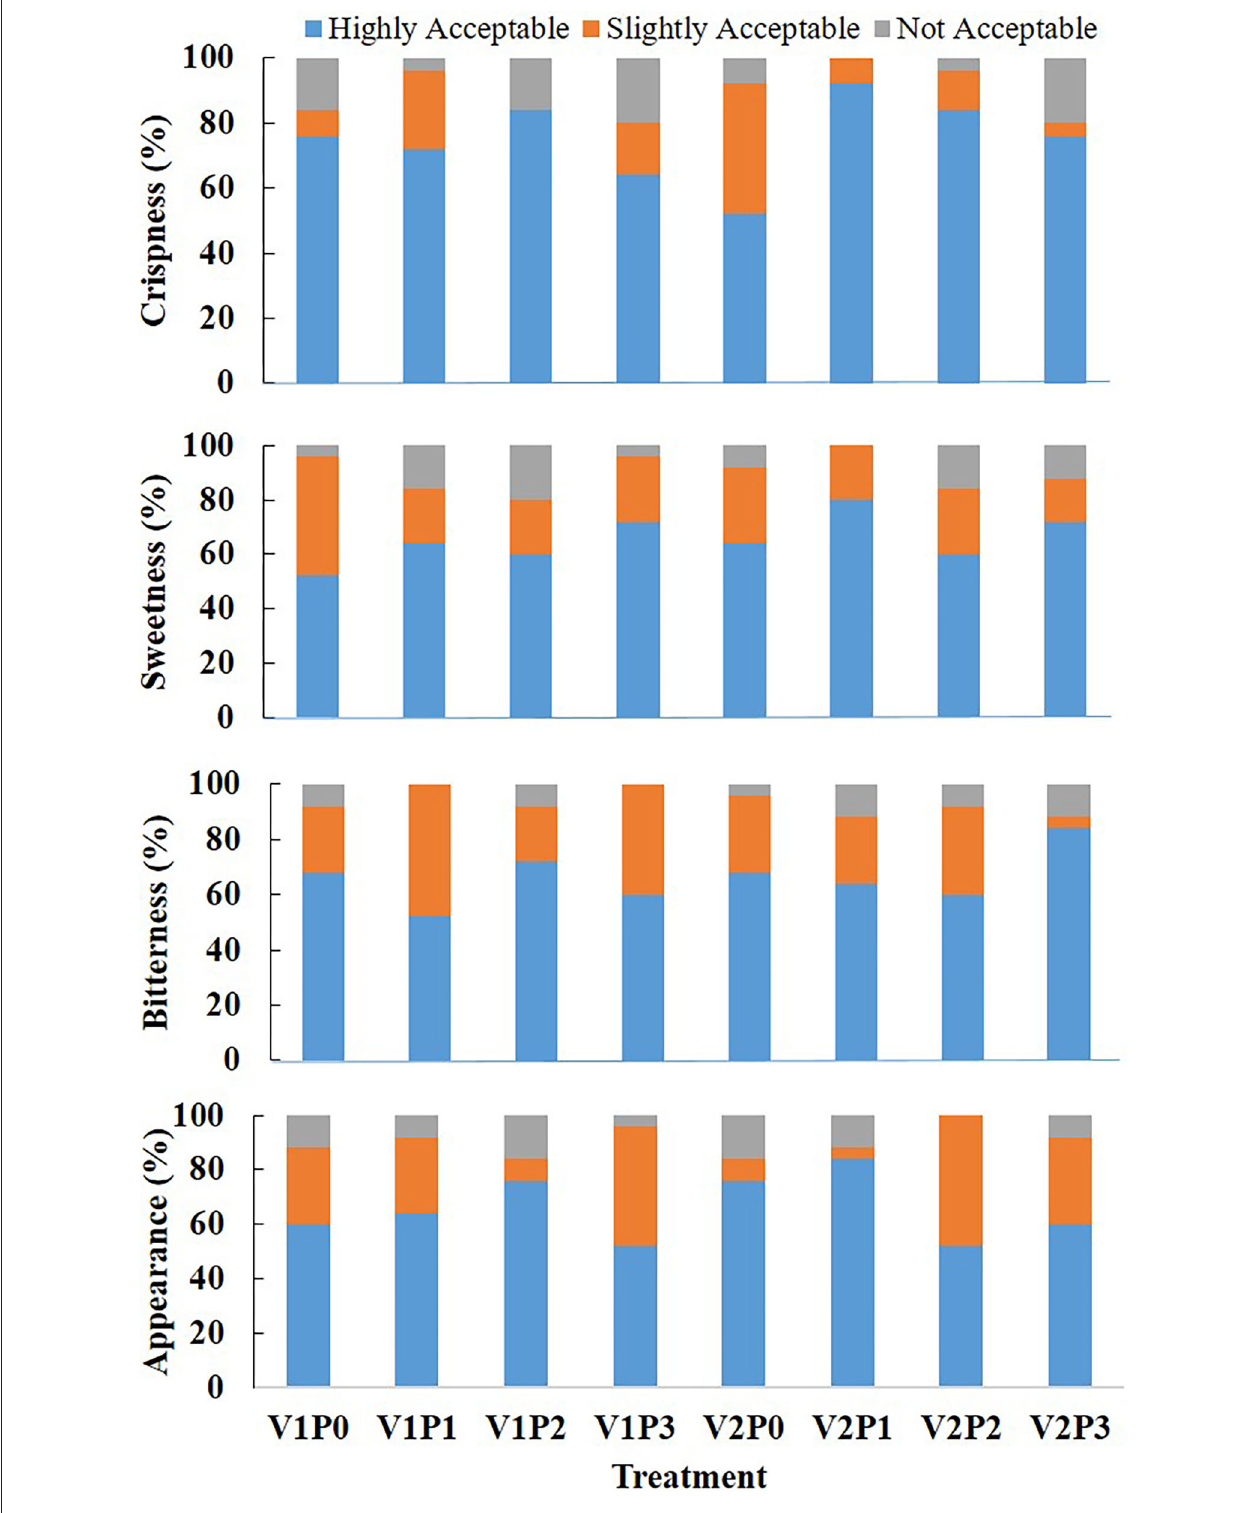
FIGURE 3 | Sensory attributes of lettuce cultivars ( Lactuca sativa cv. Green Wave, V1; Lactuca sativa cv. New Red Fire, V2) grown in different organic growing media (P0: control, 100% soil; P1: 40% soil + 40% vermicompost + 20% cocodust; P2: 50% soil + 50% vermicompost; P3: 20% soil + 40% vermicompost + 40% spent mushroom compost). A 25 members judge panel was formed to assess the sensory qualityies of lettuce (appearance, bitterness, sweetness, crispiness).